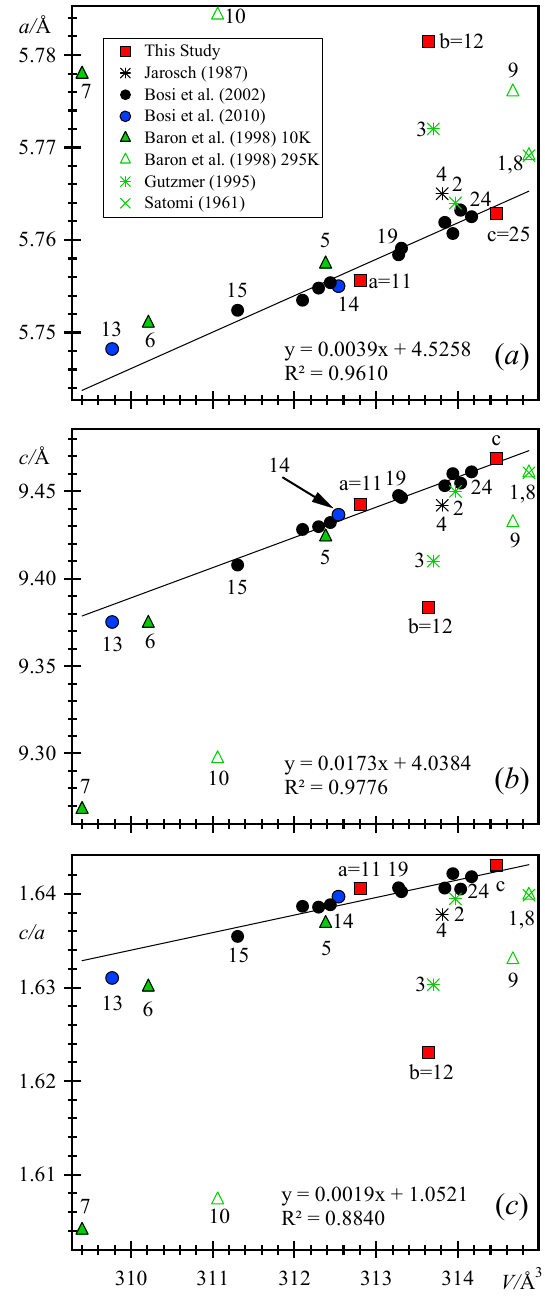
Figure 3. Linear variations among unit-cell parameters for hausmannite solid solutions (data from Table 1): ( a ) a vs. V , ( b ) c vs. V , and ( c ) c / a vs. V . Neutron data at 10 K (5–7 in Table 1; solid green triangles) are incorrectly calculated at 295 K (8–10; open green triangles). At room temperature,